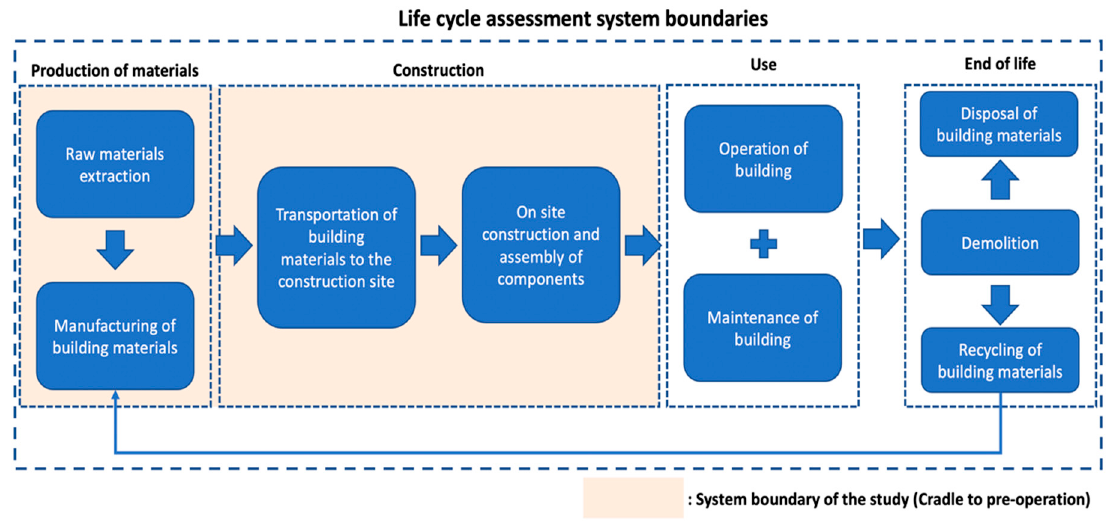
Figure 2. System boundary of this study.